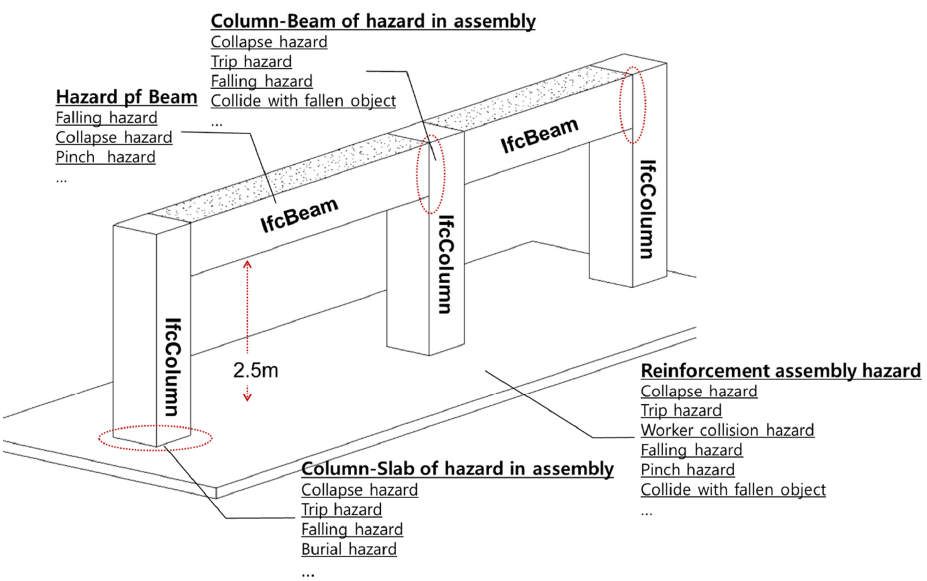
Figure 3. Hazards of IfcBeam-IfcColumn-IfcSlab. 9